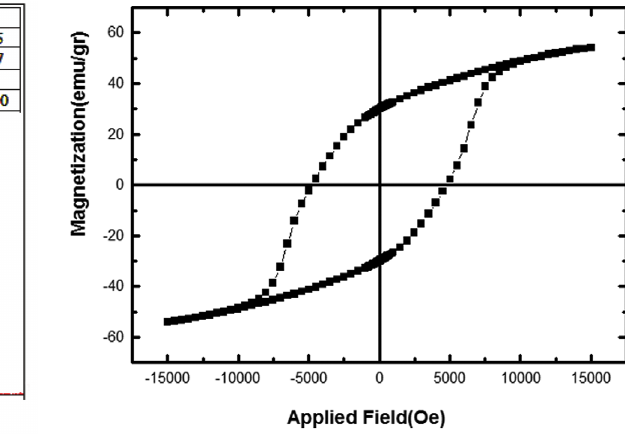
Figure 17: VSM of nanoparticle SrFe